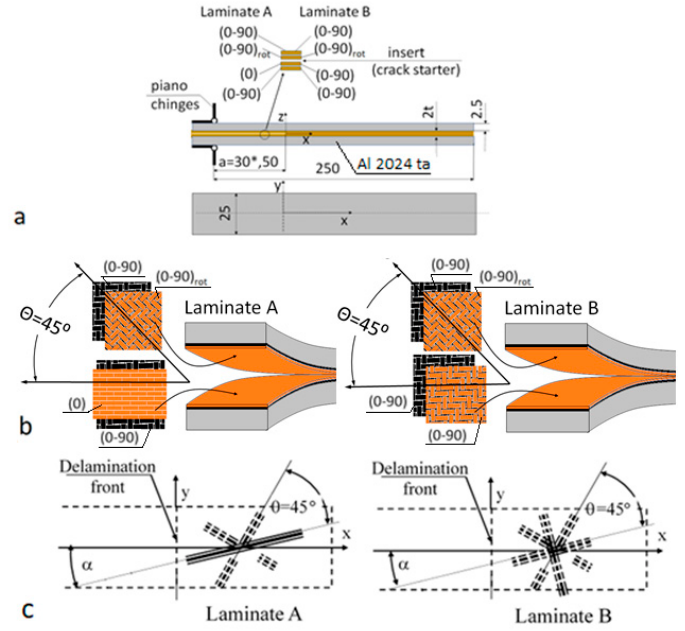
Figure 4. Hybrid beam specimen: ( a ) overall dimensions and design; ( b ) reinforcement arrangement; ( c ) definition of α .